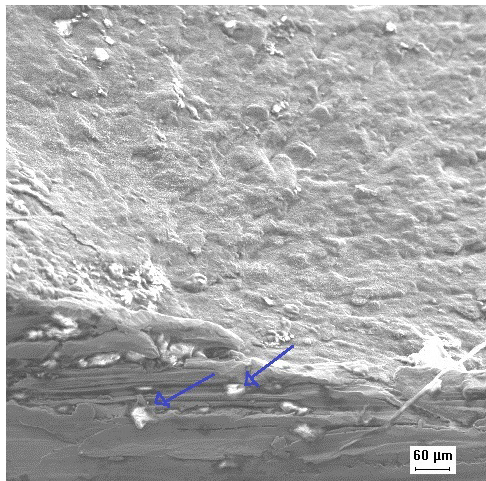
Figure 14. SEM images of the fracture surface of the P2 blade. Showing debris generated by fretting (blue arrows) located near the leading crack nucleation site.